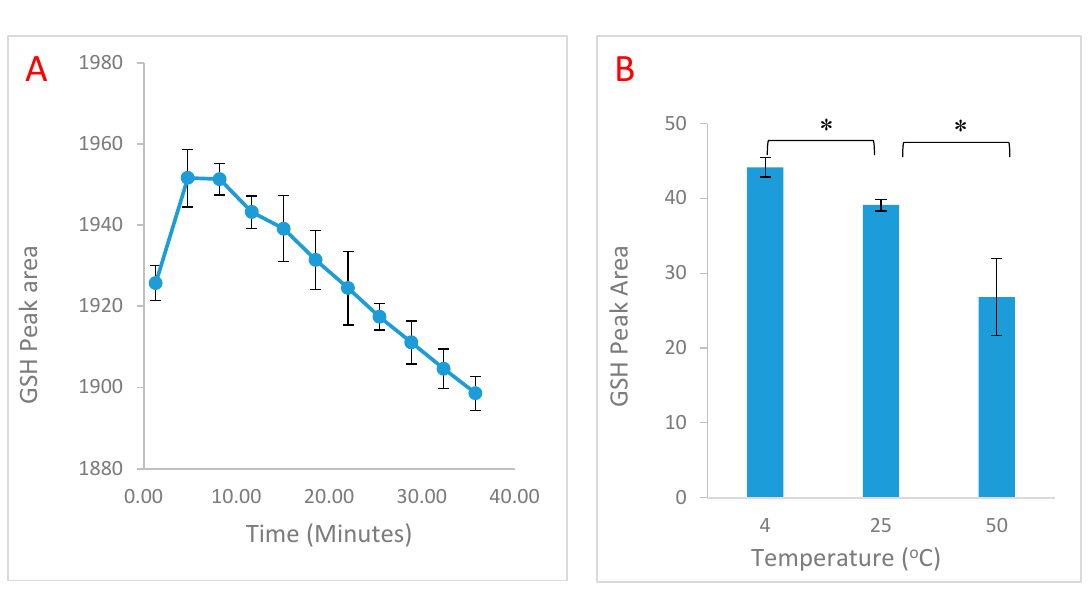
Figure 3. ( A ) Optimal incubation time required of 4 mM reduced glutathione (GSH) with 5% O-pthaldialdehyde (OPA) and subsequent degradation. ( B ) 200 µ M GSH run at di ff erent assay temperatures. Data are presented as mean ± standard error of mean (SEM) ( n = 5, * p <